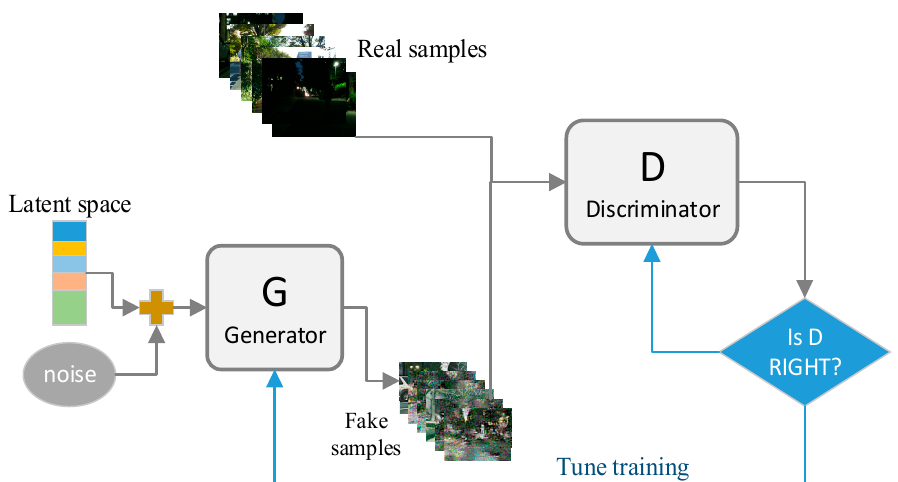
Figure 4. Classic GAN network structure.